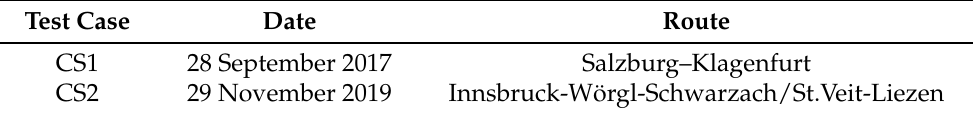
Table 3. Overview of the conducted case studies. Indicated are the route and date of travel. Test